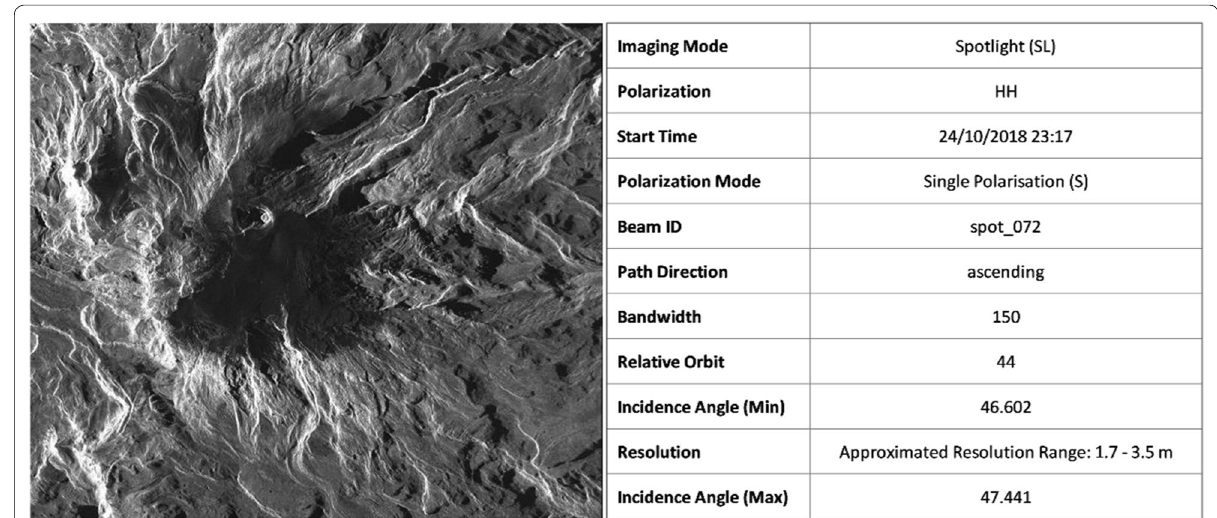
Fig. 9 Image from the NRV zone captured by satellite radar TanDEM‑X, October 24, 2018, at 23:17 (UTC). Image metadata at right side. The light blue polygon over the image represented the perimeter of the lava dome extruded at the bottom of the Arenas crater